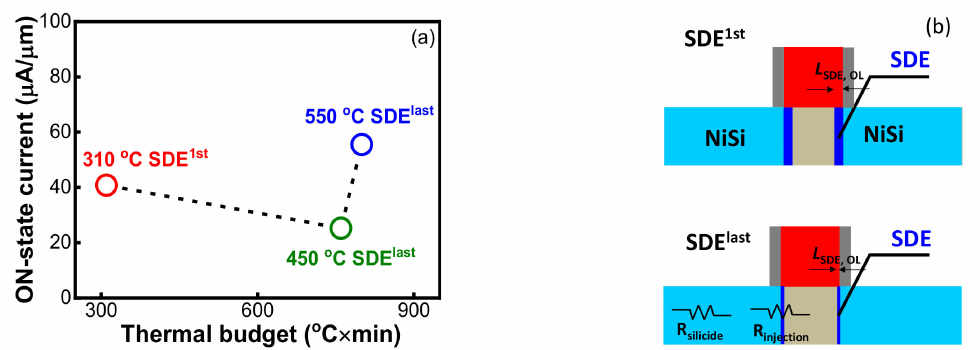
Figure 4. Cross-sectional transmission electron microscope (XTEM) images of the Schottky S/D pFinFETs ( a ) across and ( b ) along fins with gate stack covering, fabricated with 550 ◦ C SED last process.